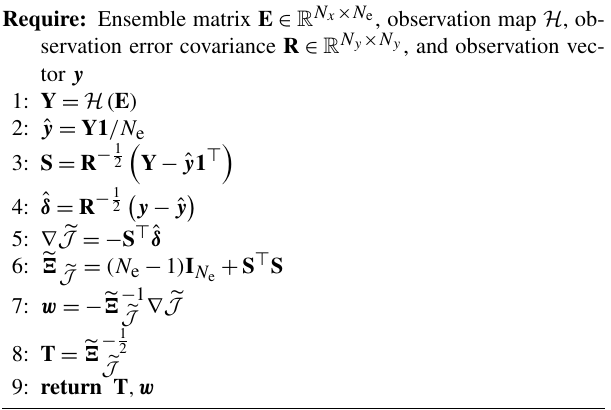
Algorithm A2 Random mean-preserving orthogonal matrix (RO).